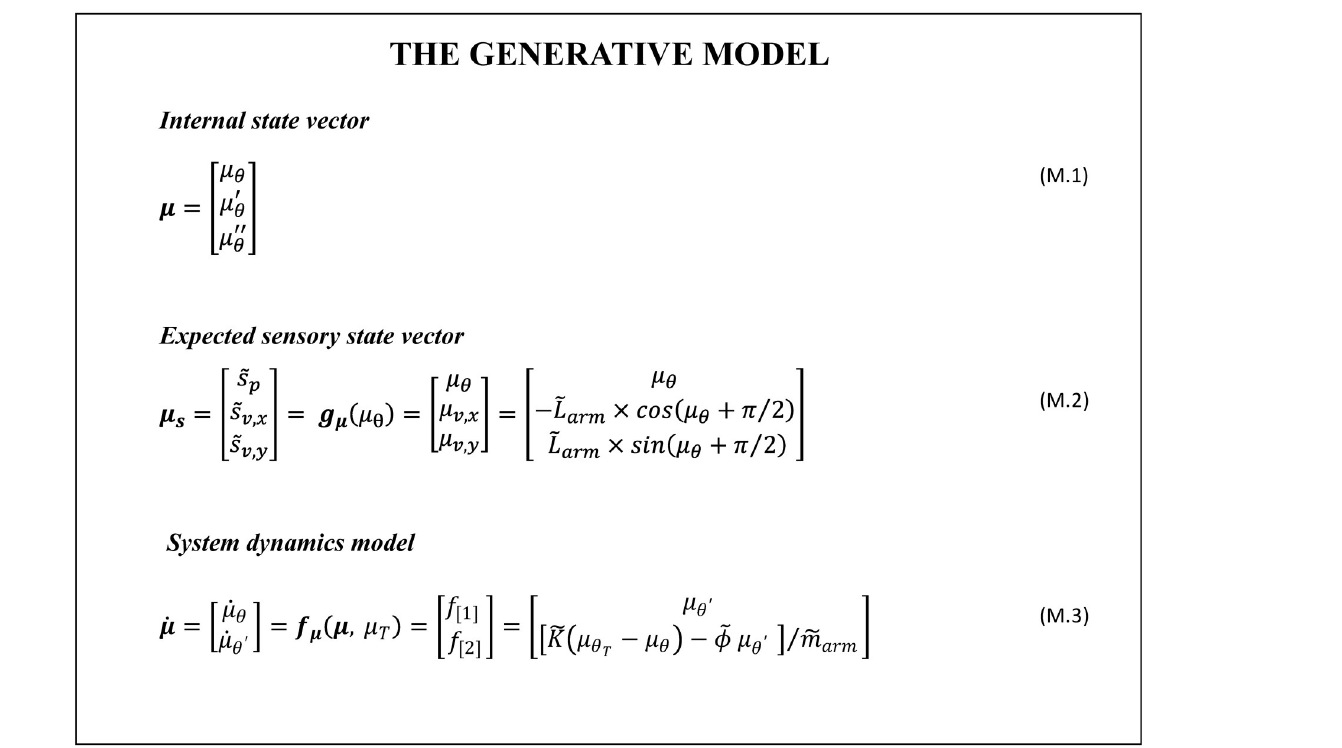
Fig 3. Mathematical description of generative model, i.e. the internal model the agent holds of the system and its dynamics, for the 1D model shown in Fig 1. The agent represents its own state via the internal state vector that describes the system in generalized coordinates at the second order (Eq M.1). The forward model, g μ (μ θ ) , describes how the agent forms an estimate of the expected sensory input based on the inferred system state, μ (Eq M.2). The model of the system dynamics allows the s agent to predict the temporal evolution of its own state. In particular, the agent in our model entails a representation of reaching actions as instantiations of a desired state, m , which acts as an attractor. The dynamics is then assumed to follow that of a damped oscillator (Eq M.3), with K representing the elastic constant controlling the y T attraction strength, ϕ the viscosity constant of the damping, and m the mass of the agent forearm. Note that the model in Eq M.3 describes also states in which the agent arm does not intend to move; in this case the desired state is to be set to the current state, i.e. m ¼ m y T y